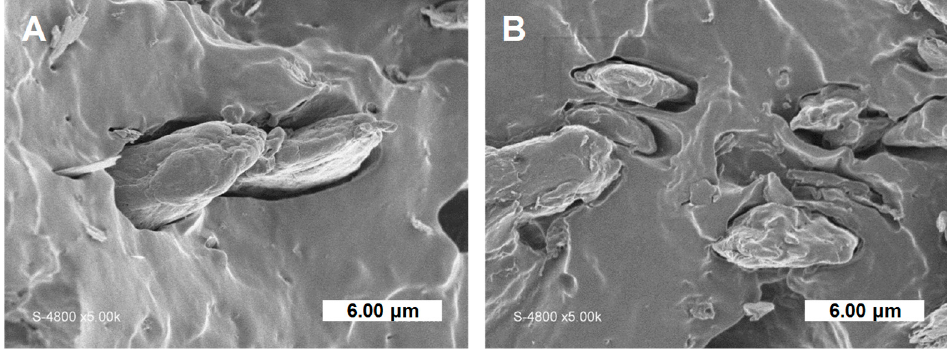
Figure 10. SEM pictures of fracture sections after tensile test: ( A ) PHBV-20VC and ( B )